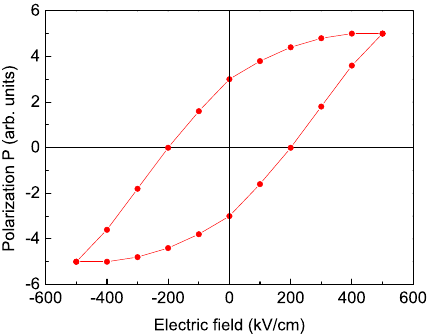
Figure 3. Electric field dependence of the spontaneous polarization P s of a YFO nanoparticle for T = 300 K, J 0 s = 0.8 J 0 b and N = 10 shells.